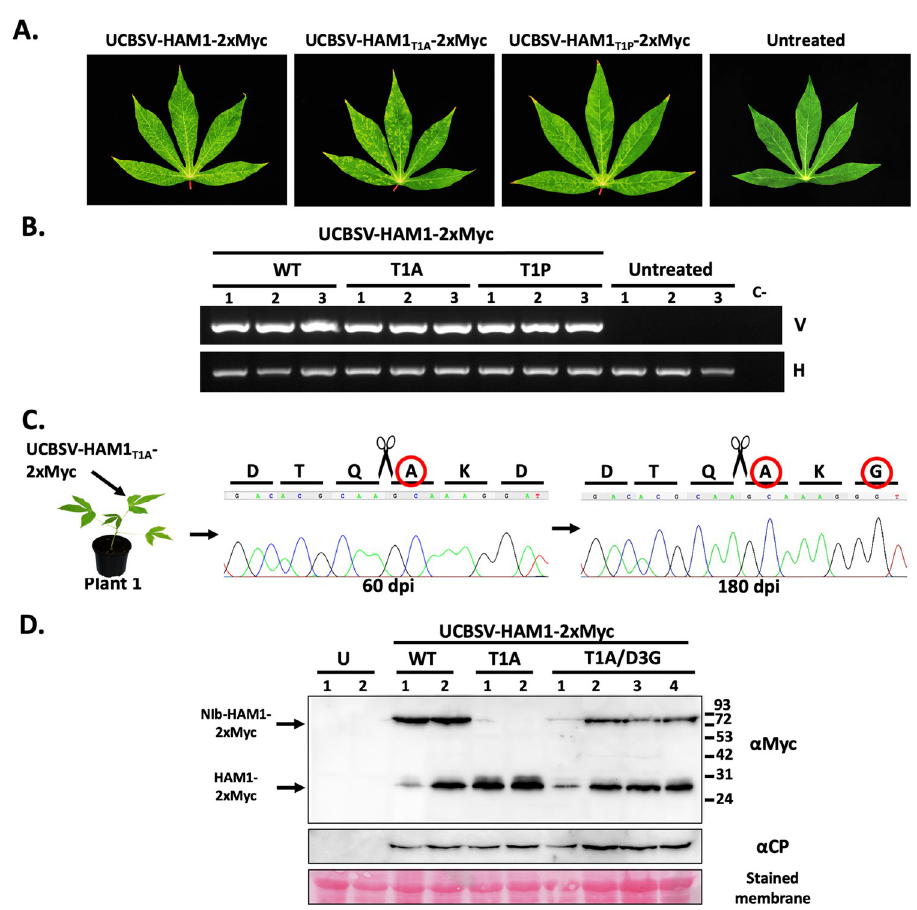
Fig 7. UCBSV HAM1 T1A mutant, which undergoes an optimal cleavage at the NIb-HAM1 junction, evolves to display partial split. (A) Representative pictures of upper non-inoculated leaves, taken at 60 days post-inoculation, of cassava plants inoculated with the indicated 2xMyc-tagged versions of UCBSV. White bar = 4 cm. (B) Analysis by agarose gel electrophoresis of a fragment of the UCBSV genome (V) and a plant housekeeping gene (H) amplified by RT-PCR. RNA samples from upper non-inoculated leaves of 3 independent cassava plants inoculated with the indicated viruses and collected at 60 dpi, were used as template. (C) Chromatograms of Sanger sequencing results of the UCBSV genomic fragment of interest amplified by RT-PCR. RNA samples from upper non-inoculated leaves of a cassava plant inoculated with the UCBSV-HAM1 T1A -2xMyc mutant were used as template. Leaves for RNA preparation were harvested at 60 and 180 dpi. Residues derived from the original mutation and from the spontaneous second mutation are surrounded by a red circle. (D) Detection of Myc-tagged HAM1 and UCBSV CP by immunoblot analysis in samples from upper non-inoculated leaves of N . benthamiana plants infected with the indicated viruses. The positions of prestained molecular mass markers (in kilodaltons) run in the same gel is indicated to the right. Blot stained with Ponceau red showing the large subunit of the ribulose-1,5-bisphosphate carboxylase-oxygenase is included at the bottom as a loading control. proposed NIaPro cleavage site at the NIb/HAM1 junction in both viruses [11] does not fit the conventional conservation rules. CBSV has a V at P1’, which is not a common residue at this position with a representation of 1.4% [42] (Fig 6A). In the case of EuRV, P1 is occupied by R, which is a strongly underrepresented amino acid at this position with a representation of 0.3% [42] (Fig 6A). Therefore, we hypothesized that HAM1 also remains bound to CBSV and EuRV NIbs. To test this idea, and due to the lack of infectious cDNA clones for these two viruses, we transiently expressed 4xMyc c-terminal tagged versions of NIb-HAM1-CP either with or with- out the presence of their cognate NIa (VPg-NIaPro) proteinases (Fig 8A). We did the same with the equivalent fragments of UCBSV as control for comparison. As expected, the